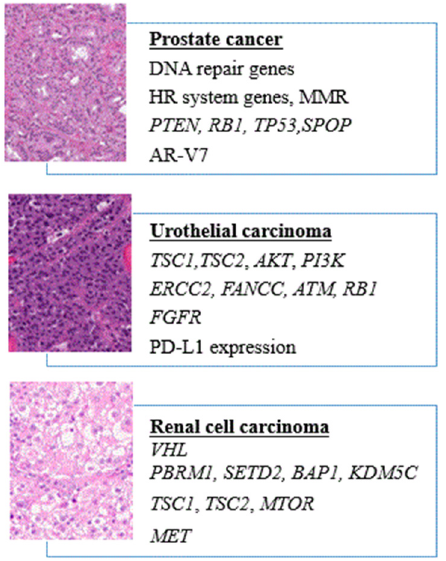
Figure 1. Potential prognostic and predictive genes and surface markers detectable in circulating tumor cells (CTCs) in prostate carcinoma, urothelial carcinoma, and renal cell